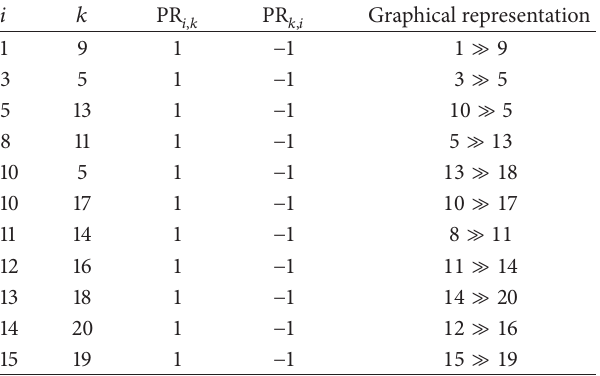
Table 11: Precedence relations among the 20 panel blocks to be